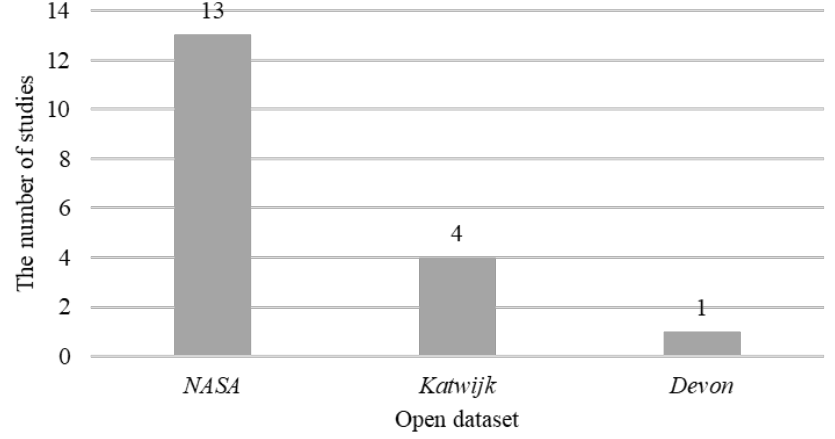
Figure 11. The number of open datasets in the Included Study . The “NASA”, “ Katwijk ”, and “ Devon ” refer to the NASA image set of Mars Exploration Rovers, the Katwijk beach planetary rover dataset, and the Devon Island rover navigation dataset, respectively. Table 13. The study of the open datasets in Figure 11. Open Dataset